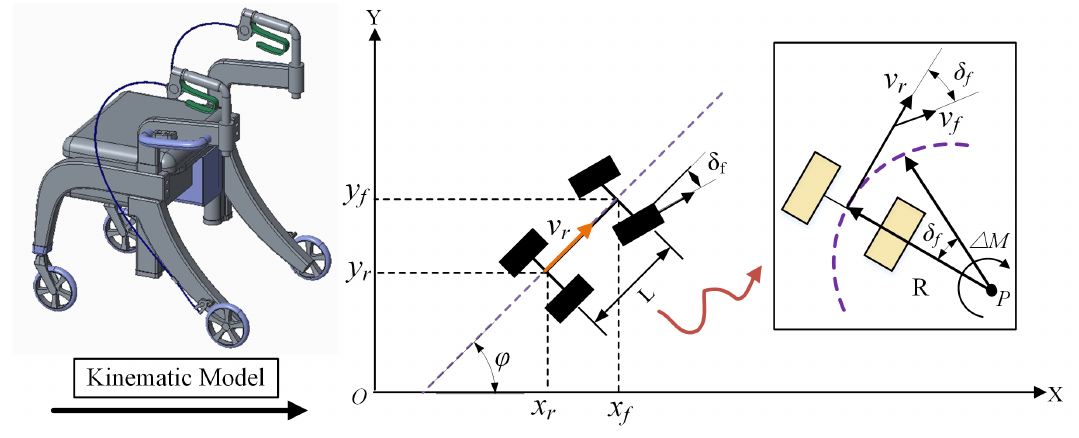
Figure 5. Kinematic model of four-wheeled